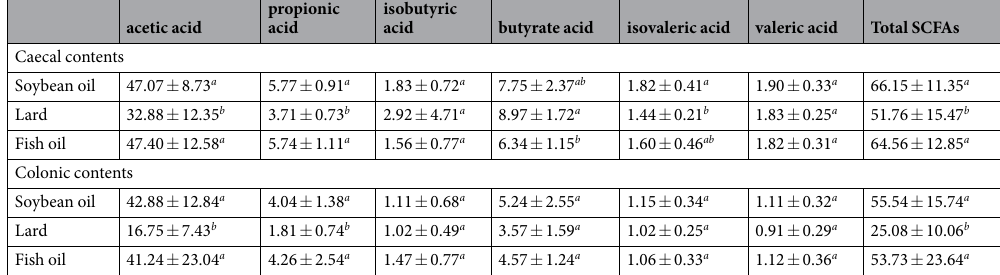
Table 1. SCFAs levels in the cecum and colon in response to different dietary fats (mmol/L). a , b Means with different superscripts differed significantly (P < 0.05). The numerical value is composed of the mean and the standard deviation.